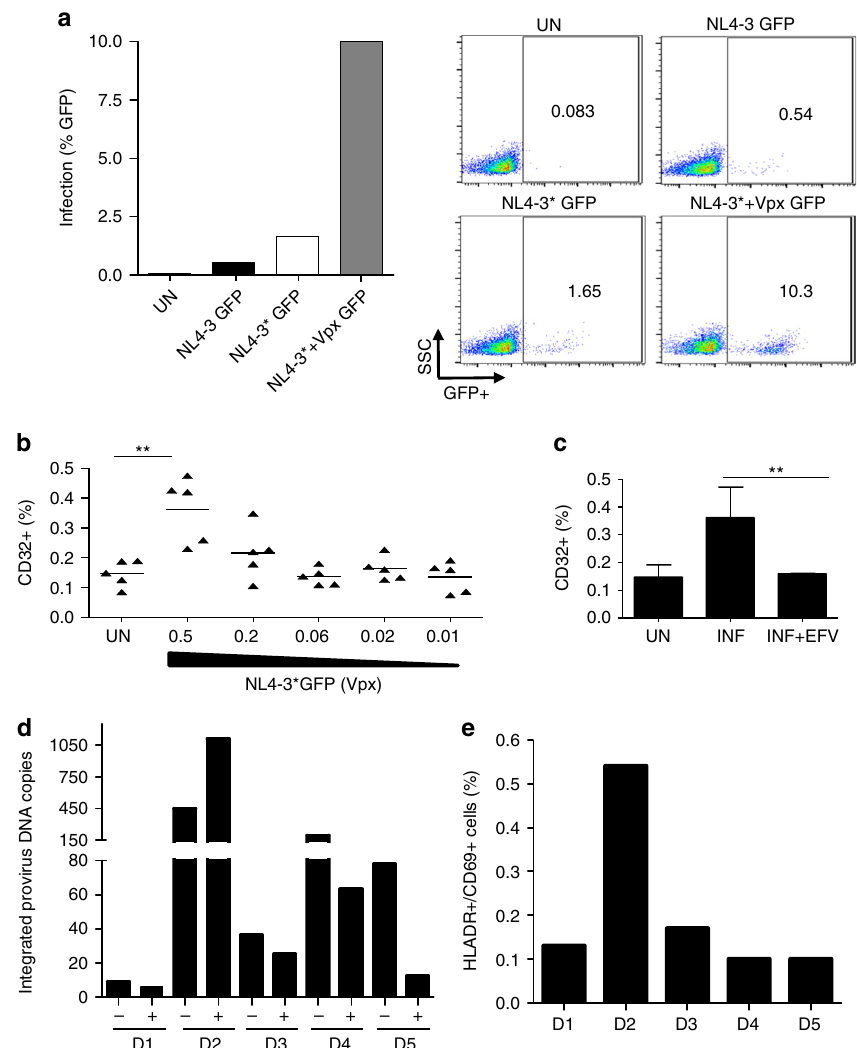
Fig. 4 Contribution of HIV-1 proviral DNA in CD32 + /CD4 + T cells from in vitro infections. a Infection of CD4 + T cells treated with IL-2 and infected with NL4-3GFP, NL4-3*GFP, and NL4-3*GFP carrying Vpx. The percentage of infection was evaluated using fl ow cytometry; representative dots are shown on the right. The data from a representative donor are shown. b Percentage of CD32 cell surface expression measured by fl ow cytometry and infected with different multiplicities of infection of HIV-1 NL4-3 carrying HIV-2 Vpx or uninfected (UN) ( n = 5). Lines represent mean values. c Upregulation of CD32 expression after infection (INF) is reduced concomitant to blockade of HIV-1 infection with efavirenz (INF + EFV) The data represent the mean ± SD of fi ve different donors. For ( b ) and ( c ) Student ’ s t -test, ** p < 0.005. d Integrated HIV-1 DNA copy number in sorted CD32 + and CD32 − cells of fi ve different donors infected with NL4-3*(Vpx). Measurement of integrated proviral DNA was performed by pre-amplifying an LTR DNA fragment with equal amount of genomic DNA input (100 ng) from the sorted CD32 + or CD32 − population. Absolute quanti fi cation was obtained in a second ampli fi cation of HIV-LTR by qPCR. The data from each donor are shown. e Activation level of CD4 + T cells from fi ve uninfected donors as measured as the expression of HLA-DR